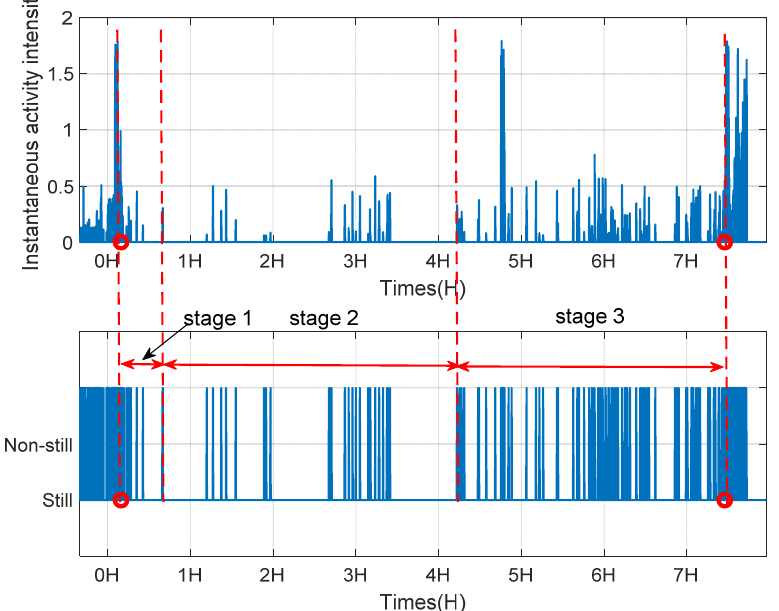
over weeks or months could be a good indicator for one’s sleep quality (especially for very abnormal patterns). In this paper, we used the accumulated body movement time during sleep to represent the body movement frequency. Figure 25 shows the accumulated mo- tion time during sleep of all the volunteers, the first 14 days are the accumulated motion time of volunteer 1. Only consider volunteer 1, we can find that during the 14 days, the accumulated motion time in the ninth and tenth day are much longer than the other twelve days. Through compared with the corresponding ground-truth video, we can find that the volunteer 1 suffered from insomnia for some reason in those two nights.